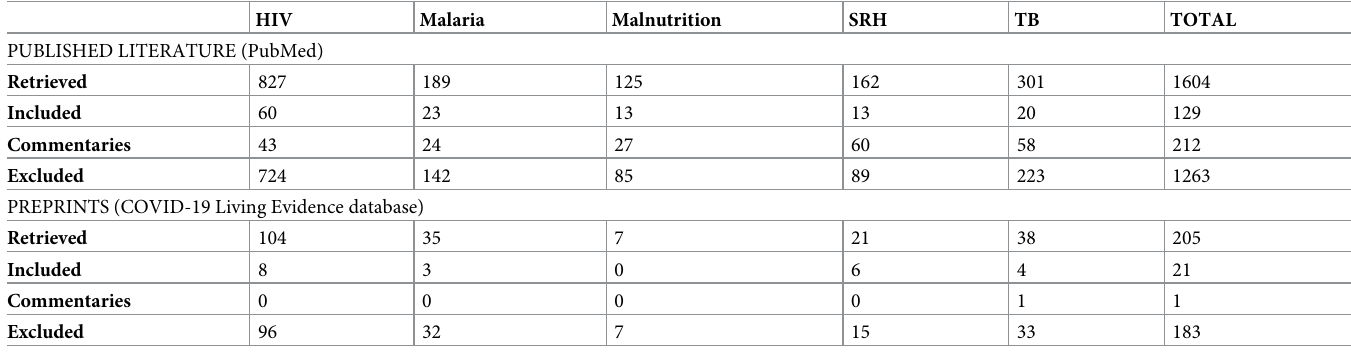
Table 1. Number of papers pulled, included, marked as relevant commentaries, and excluded by competing health risk as part of the scoping